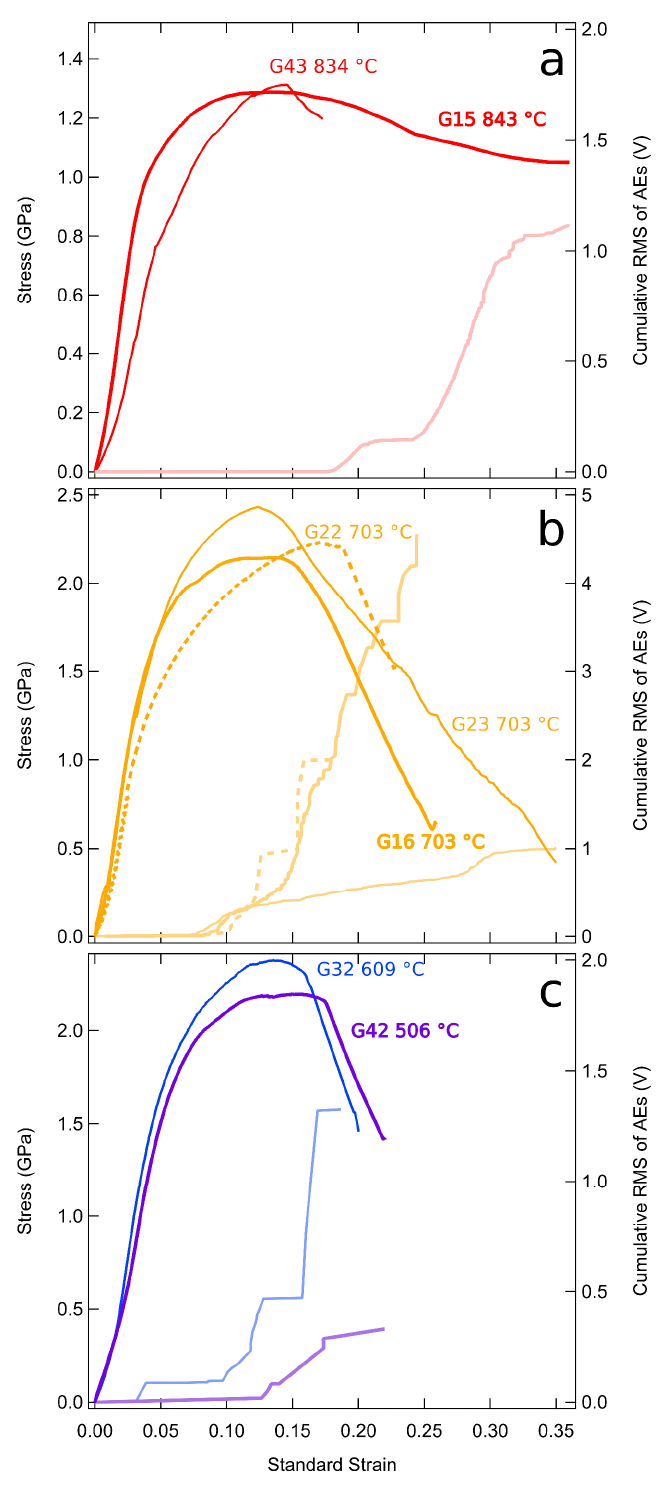
Figure 4. Evolution of differential stress with sample strain. The associated cumulative RMS values for AEs are given with the light-coloured curves. Horizontal axis is the same on all panels. Thicker curves correspond to faster strain rates (Table 1). ( a ) High-temperature experiments. No AEs were collected during G43. ( b ) Intermediate temperature experiments. Dashed lines represent experiment G22, where a smaller Ge-olivine sample was used, sandwiched between two Ge-spinel samples. ( c ) Low-temperature experiments.